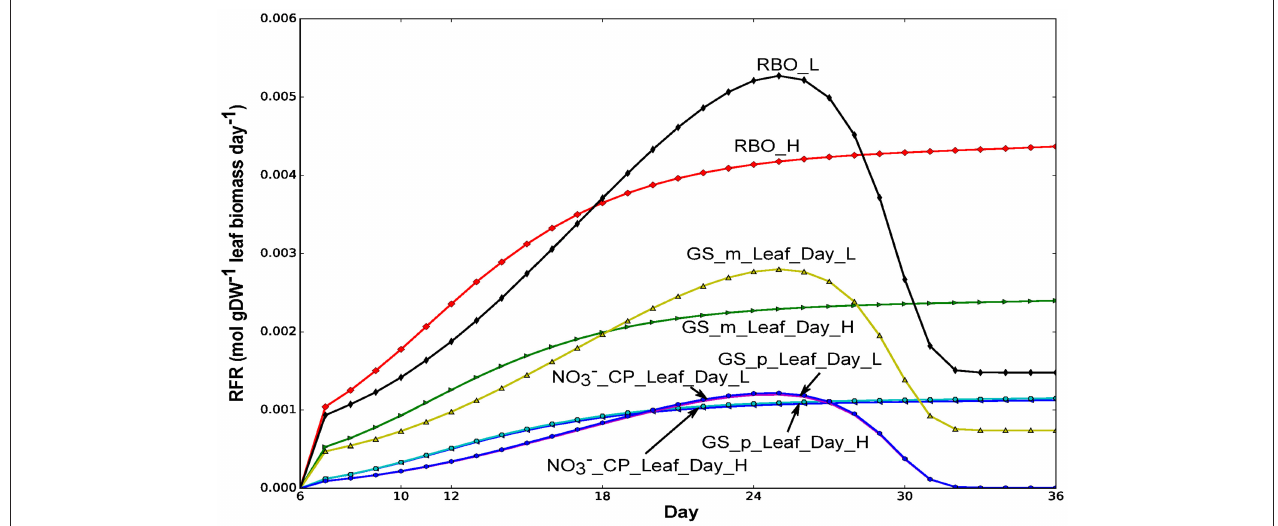
FIGURE 5 | Fluxes of glutamine synthetases (GS) in leaf and nitrate transport from common pool to leaf. Flux values were normalized to per gram leaf biomass. _m and _p represent mitochondrial and plastidic GS, respectively. RFR, relative flux